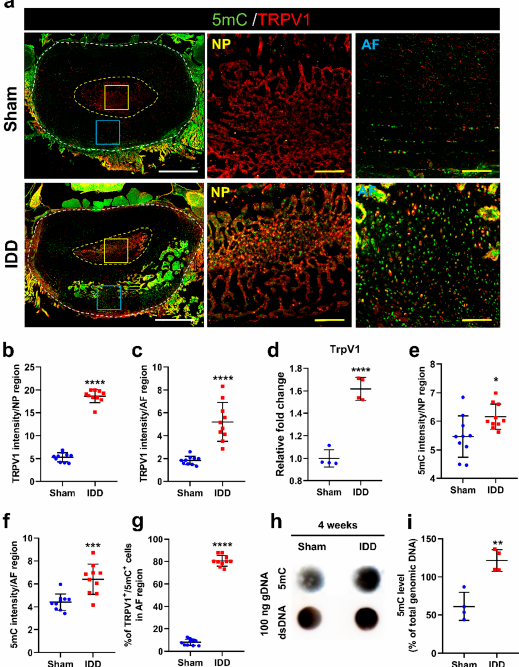
Figure 4. ( a ) Representative immunohistochemical low and high images for 5mC (green) and TrpV1 (red) in the NP and AF regions of the sham and IDD groups. White scale bar = 1000 µm, Yellow scale bar = 100 µm; ( b , c ) Relative intensity of TrpV1 expression in the NP and AF regions of the sham and IDD groups ( n = 10/group); ( d ) Relative fold change of TrpV1 mRNA levels in the sham and IDD groups ( n = 4/group); ( e , f ) Relative intensity of 5mC expression in the NP and AF regions of the sham and IDD groups ( n = 10/group); ( g ) Percentage of double-stained cells with TrpV1 (red) and 5mC (green) in the AF regions of the sham and IDD groups ( n = 10/group); ( h ) DNA dot blot results for 5mC levels in the L4/5 and L5/6 discs of the sham and IDD groups at 4 weeks; ( i ) Quan- titative results from dot blot assay of 100 ng of DNA for 5mC normalized with the total amount of genomic DNA in the sham and IDD groups ( n = 4/group). Data are expressed as the mean ± SEM. Significant differences indicated as * p < 0.05, ** p < 0.01, *** p < 0.001, and **** p < 0.0001 vs. sham group were analyzed via unpaired t -tests with Welch’s correction. 5mC, 5-methylcytosine; AF, an- nulus fibrosus; IDD, intervertebral disc degeneration; NP, nucleus pulposus; SEM, standard error of the mean; TrpV1, transient receptor potential vanilloid subtype 1.